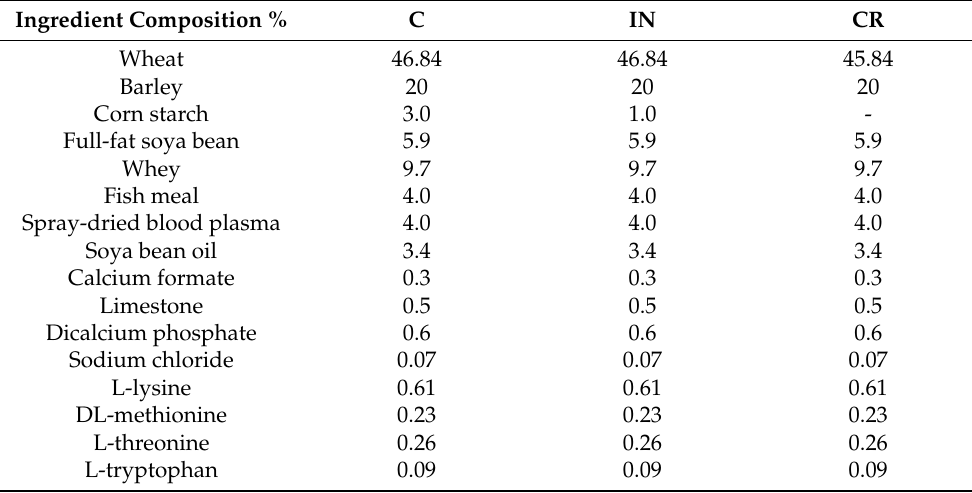
Table 1. Ingredient compositions of the control (C) and experimental diets (IN,